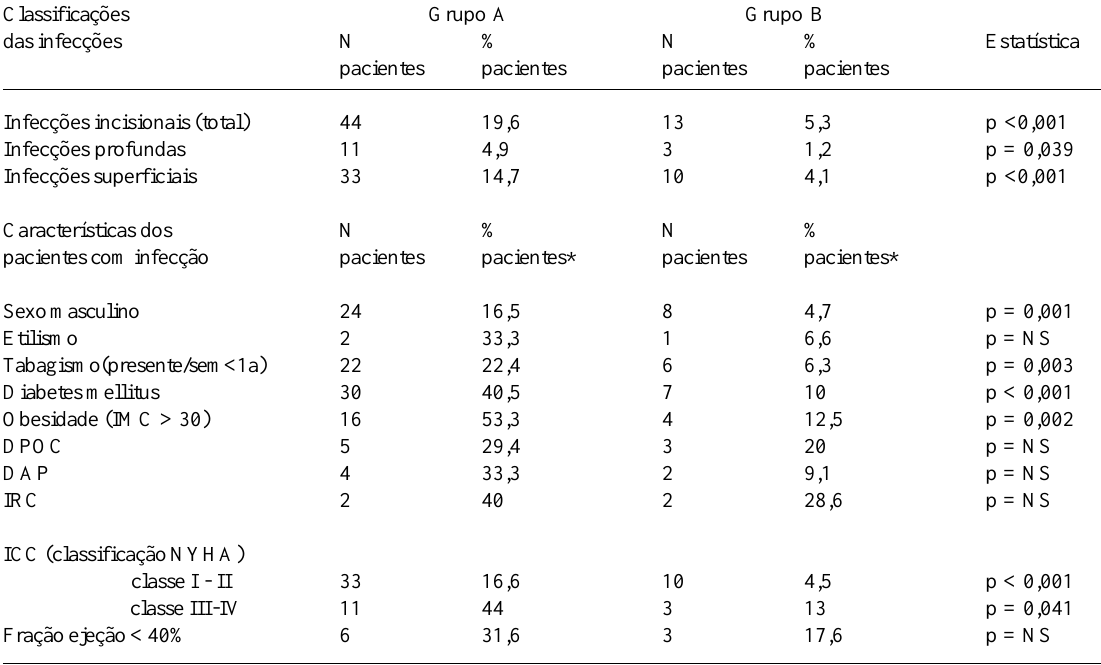
Tabela 4. Incidências das infecções em cada grupo e características dos pacientes infectados.